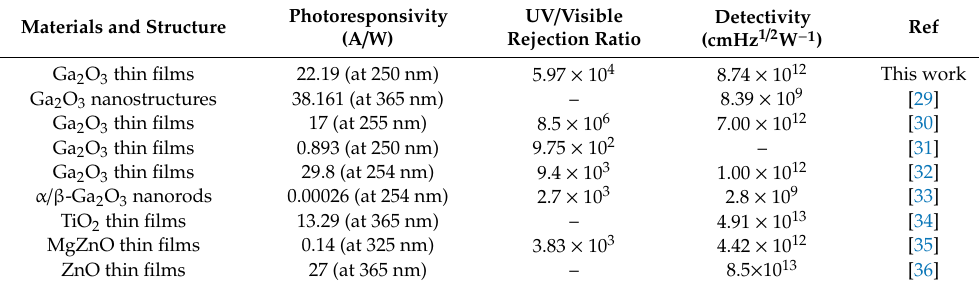
Table 1. Comparison of the performance of metal oxide-based MSM